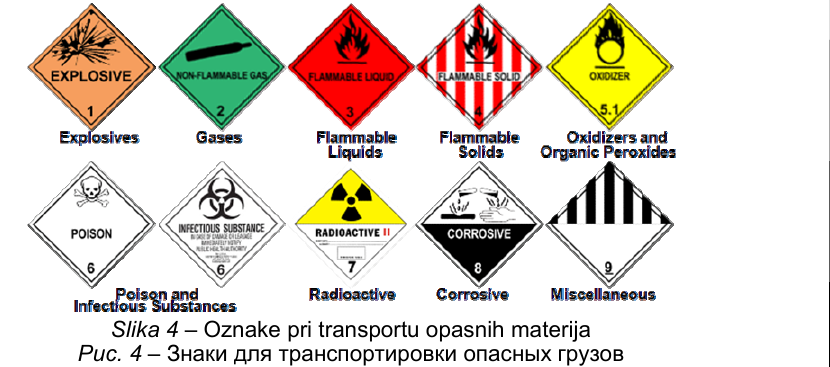
Figure 4 – Labels when transporting hazardous